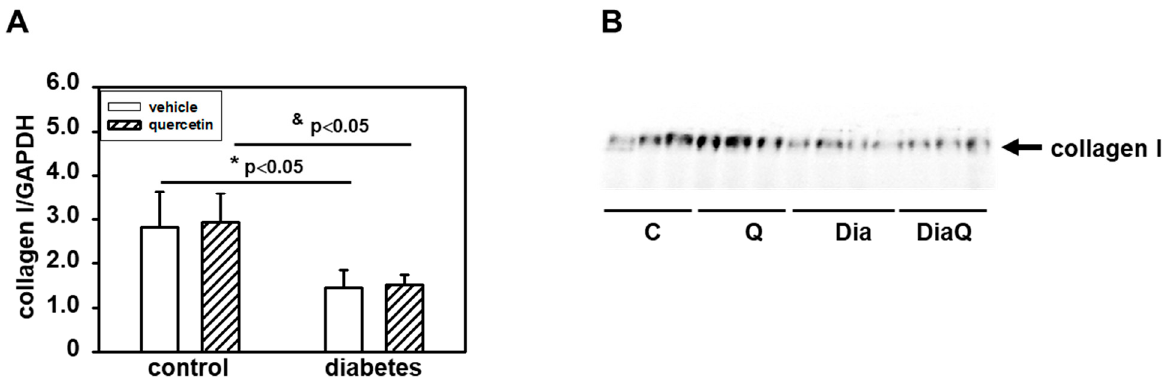
Figure 5. Effects of quercetin treatment on collagen I content in left ventricular tissue of control lean and obese diabetic Zucker Diabetic Fatty (ZDF) rats. ( A ) Collagen I levels were determined by Western blot analysis using a specific antibody. Quantification of collagen I content was normalized to glyceraldehyde-3-phosphate dehydrogenase (GAPDH) protein levels. Each bar represents mean ± SEM, n = 6–7. Statistical significance was revealed by Student’s unpaired t -test, * p < 0.05 vs. control lean vehicle-treated rats, & p < 0.05 vs. control lean quercetin-treated rats. ( B ) Western blot records showing the changes in collagen I levels. C—control lean vehicle-treated ZDF rats; Q—lean quercetin-treated ZDF rats; Dia—obese diabetic vehicle-treated ZDF rats; DiaQ—obese diabetic quercetin-treated ZDF